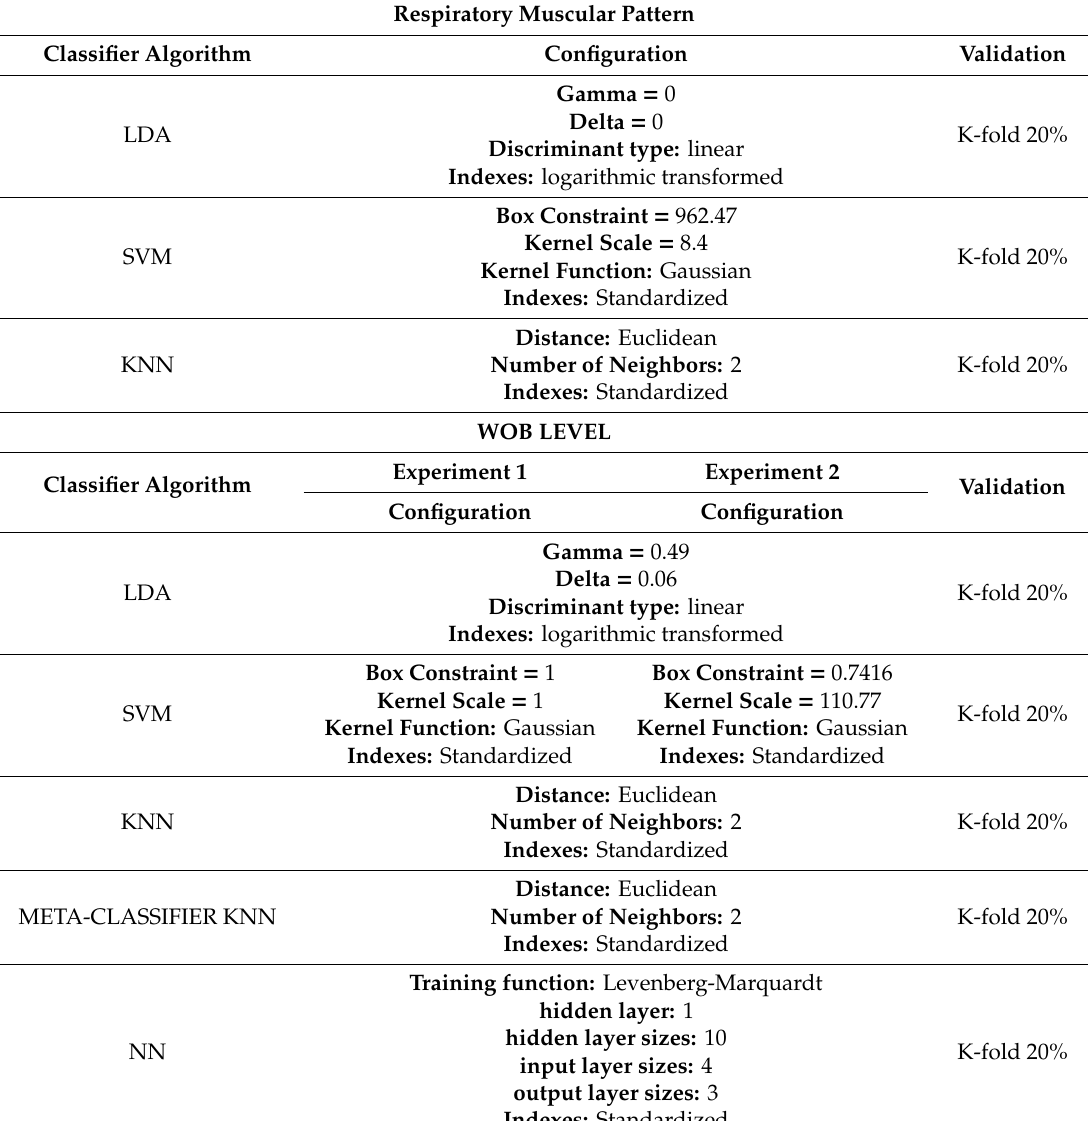
Table 2. Information about configuration and validation of each of the classification algorithms. The algorithms used in each of the cases, classification of the respiratory muscular pattern and WOB level, are specified. LDA: Linear Discriminant Analysis, SVM: Support Vector Machine, KNN: K-Nearest Neighbor, NN: Neural